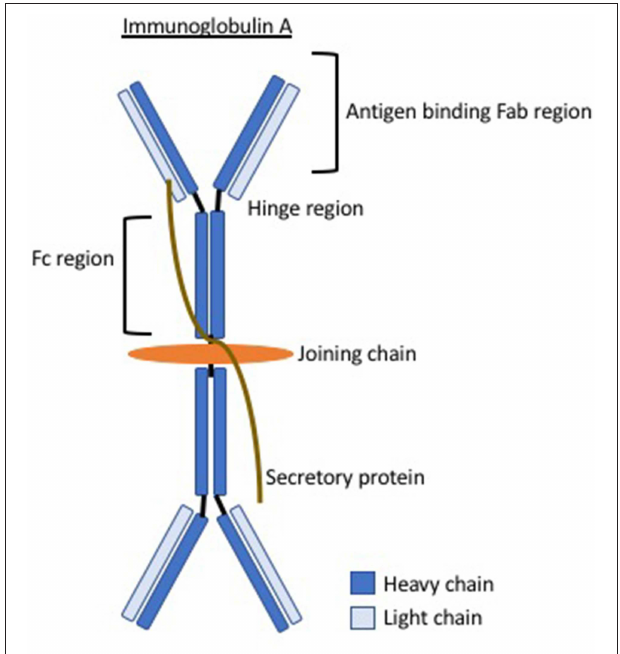
FIGURE 1 | The structure of immunoglobulin A demonstrating the hinge region where abnormalities in IgA glycosylation are believed to give rise to antibody